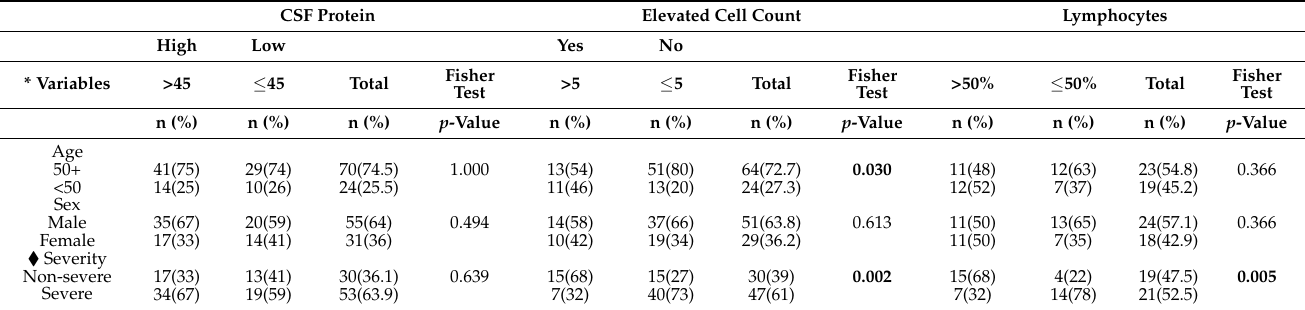
Table 4. Comparison of various demographics, severity, fatality and CNS manifestation by CSF markers. CSF